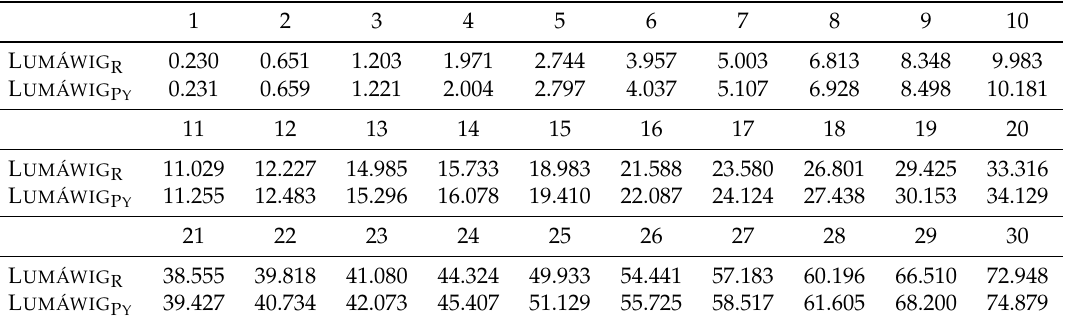
Table 1. Summary of significant decrease (at confidence level α = 0.95) in running time (in seconds) for paired tests versus H ERA . Column labels are in thousands of points.